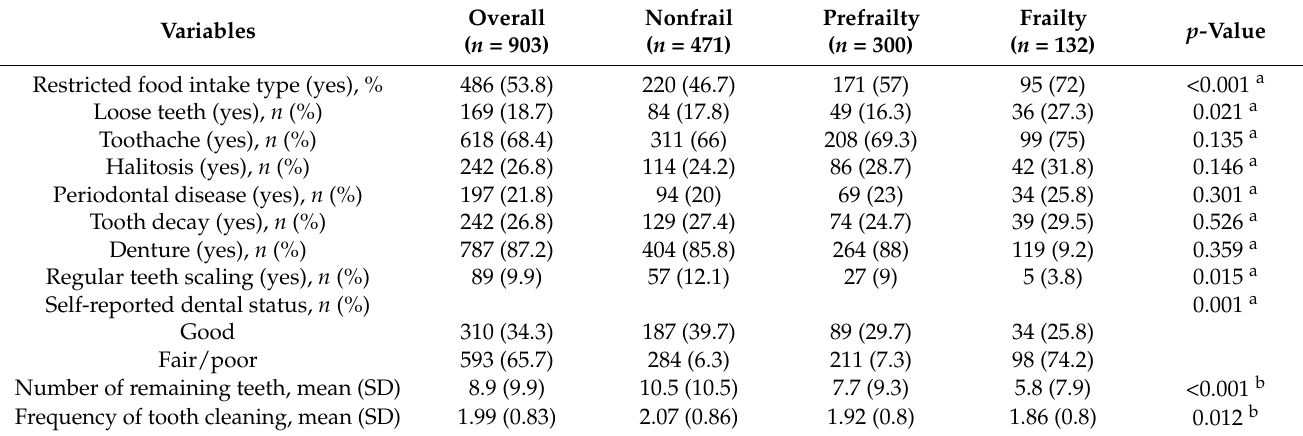
Table 2. Distribution of the participants based on self-perceived oral health.